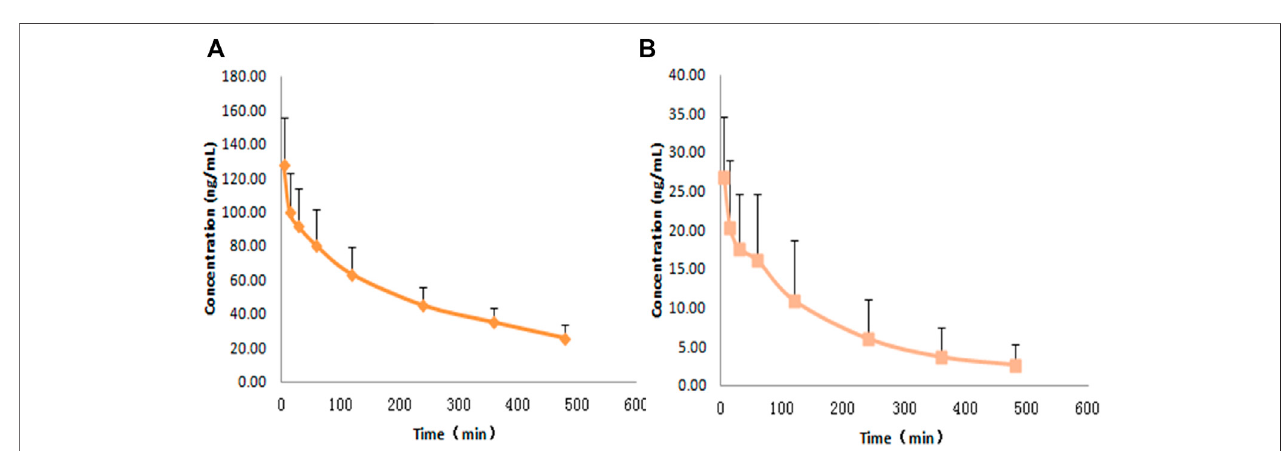
FIGURE4| Averageplasmaconcentration-timepro fi lesforRDXandHMXwithasingledoseof0.5 mlnitraminescompoundsintravenouslypumpingtorats(n=8) , (A) RDX, (B) HMX.